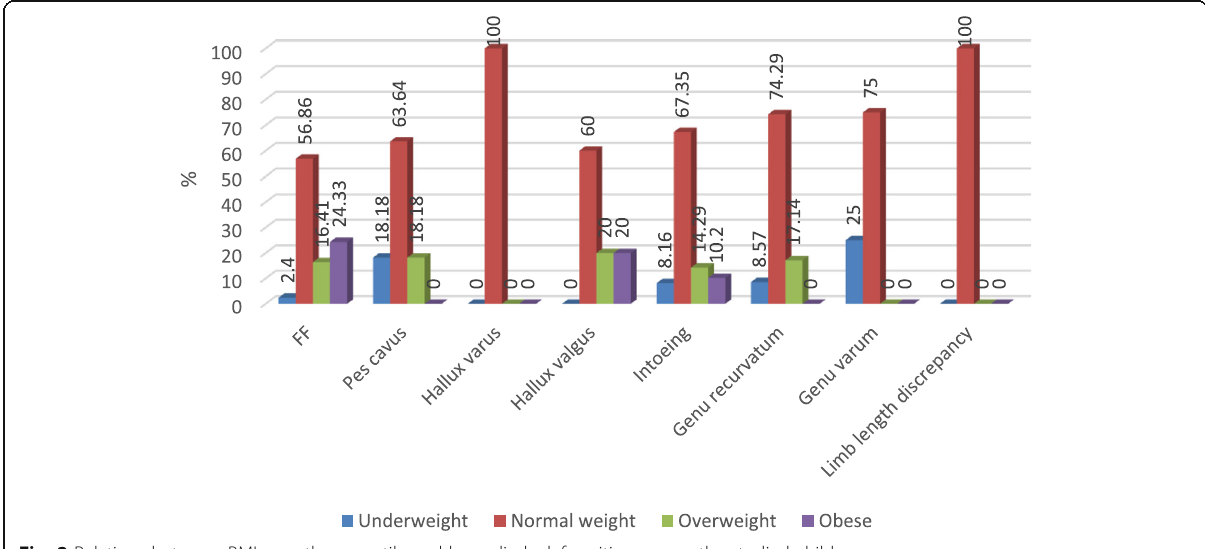
Fig. 2 Relations between BMI growth percentile and lower limb deformities among the studied